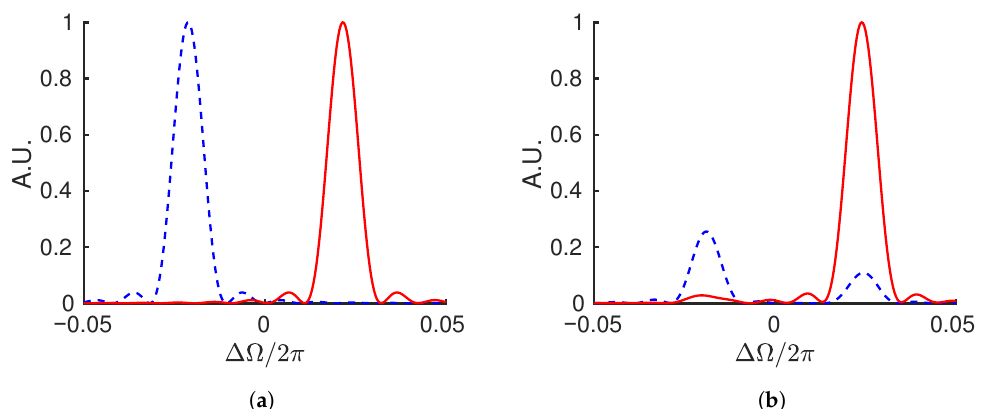
Figure 2. Numerical solution showing a pair of teeth of the two frequency combs (red,blue) defined by the time model of Equation (7) after 100 round-trips with no coupling, s = 0 ( a ), and coupling, s = 0.1 e ( 1 i ) ( b ). Both simulations were carried out with a detuning of ∆ ϕ = 0.27, gain of α 0 = 1, β 1,2 = 0.05, and W s = 1 in Equation (8), and τ p = 1. When coupling is included, the fields pass energy back and forth such that which field is dominant in plot ( b ) depends on how many round-trips are considered If taken over an infinite number of round-trips, ( b ) and Figure 4b would be symmetric, since the amplitudes of the two pulses follow similar oscillation, but out of phase. Since the variable x is in fact the time (in unit of round-trip), ( b ) and Figure 4b can be recognized as wavelet transforms. Gain Difference Exceptional